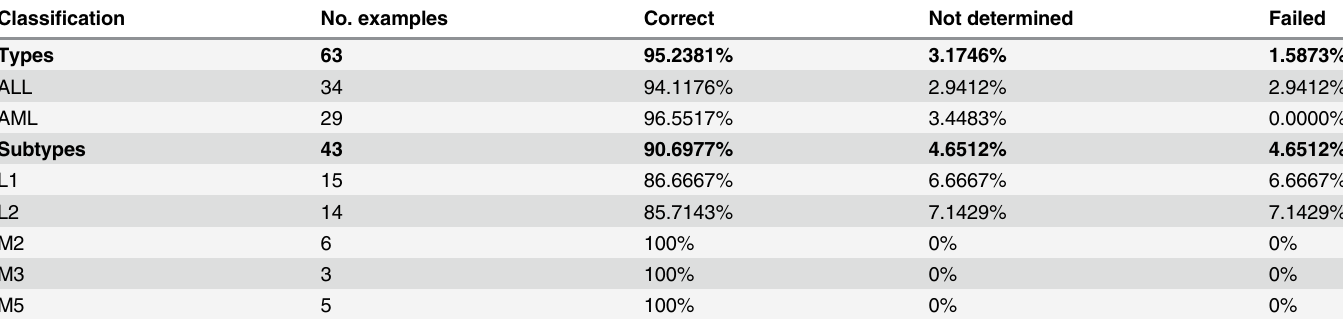
Table 7. Evaluation of the acute leukemia diagnosis algorithm by merging multi-class classifiers